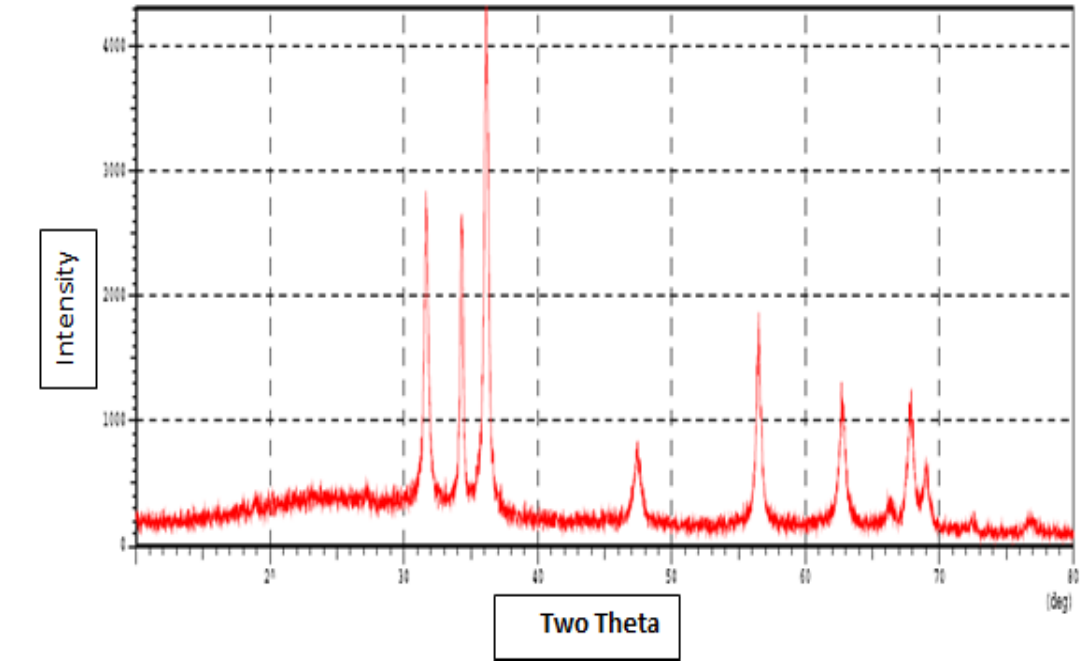
Figure 5. X-ray diffractogram of ZnONPs